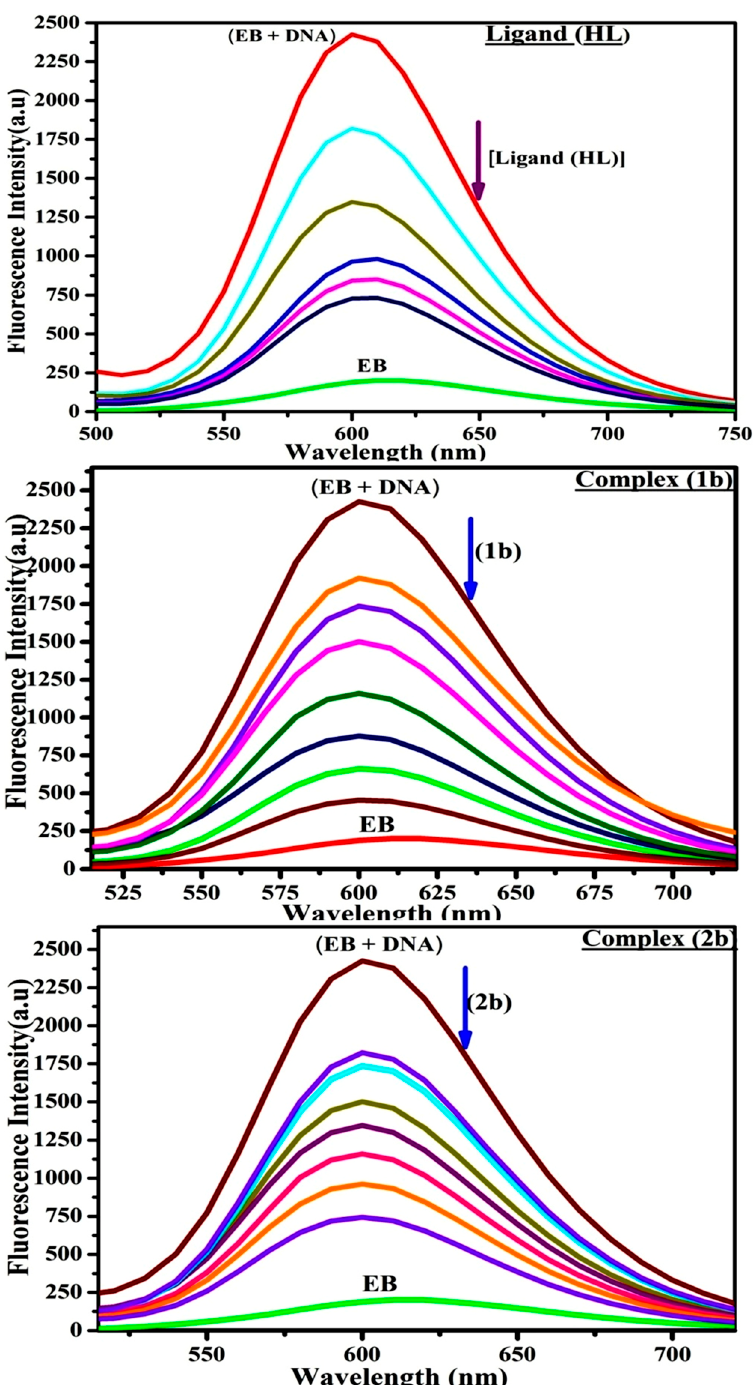
Figure 5. The fluorescence quenching curve of EB bound DNA in the presence of ligand ( HL ) and complexes ( 1b – 2b ). Concentration [DNA] = 240 µ M, and [compound] = 0–240 µ M. The fluorescence emission spectra of the EB-DNA adduct absorbed at 610